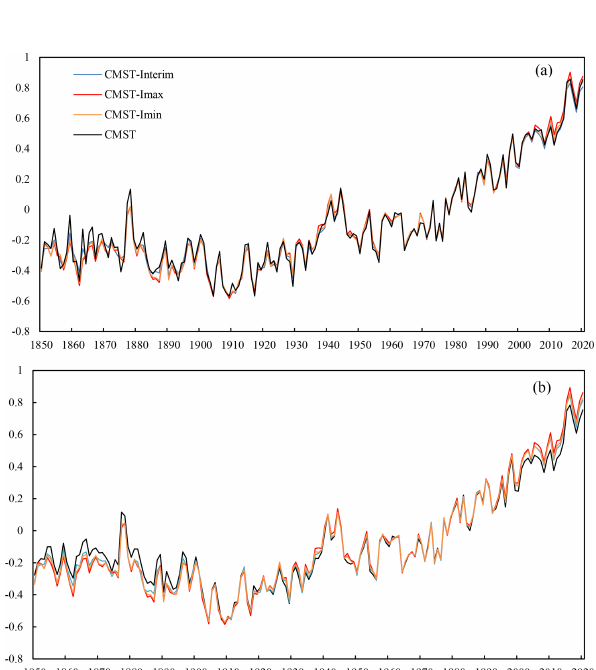
Figure 9. Comparison of GMST anomaly series (relative to 1961– 1990 average) for CMST 2.0 datasets and CMST-Interim using two methods: (a) calculated based on the weighted average of global mean LSAT and SST series according to the sea–land ratio, (b) cal- culated based on latitudinal